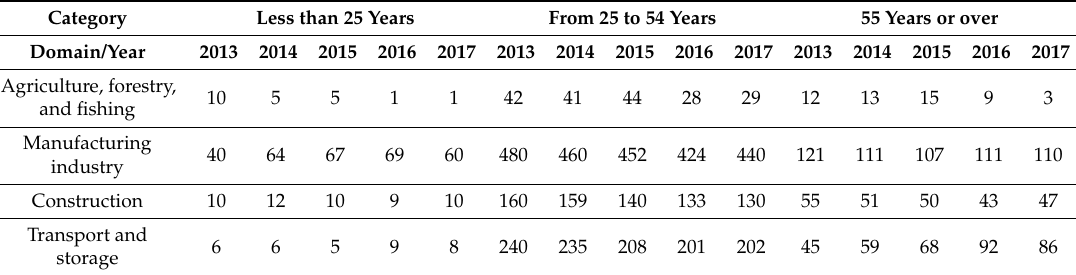
Table 5. The distribution of accidents in Bulgaria by age